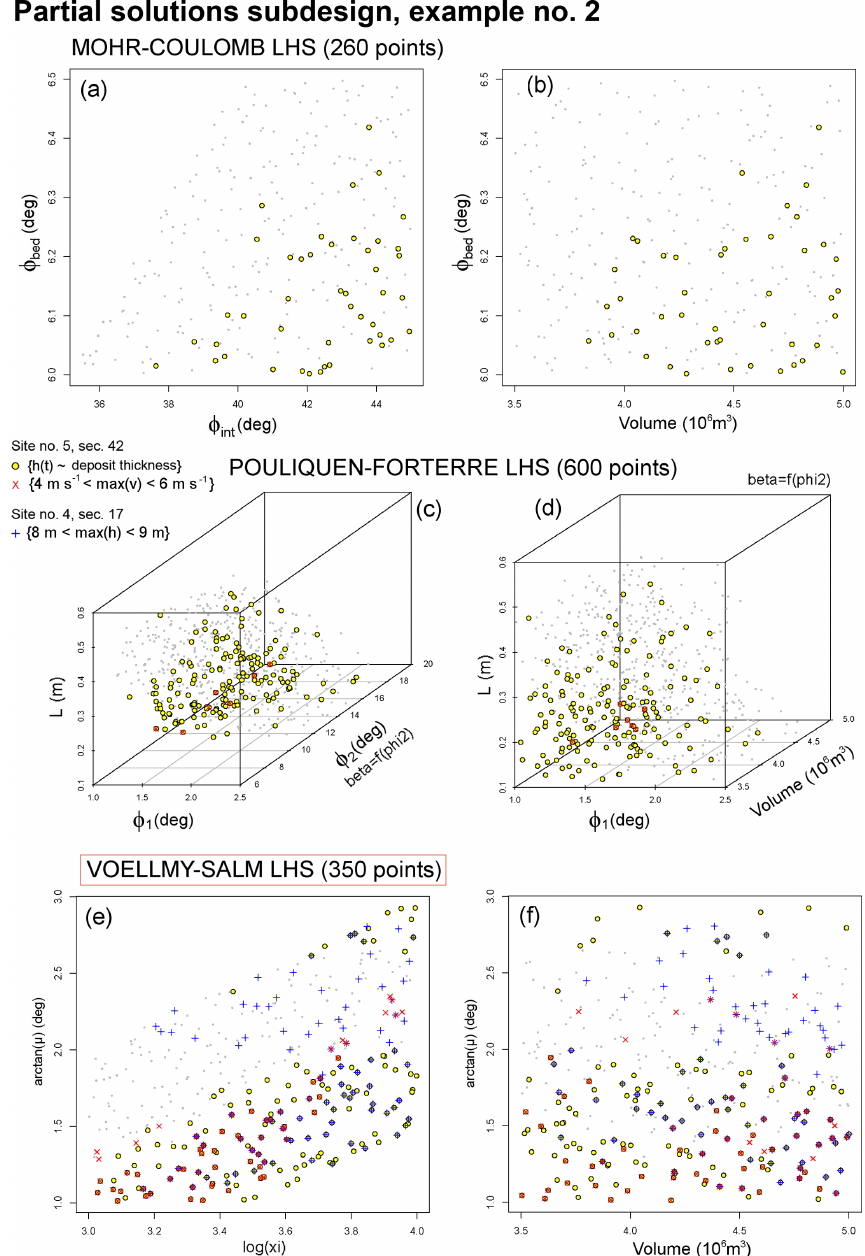
Figure 15. Example 2 of partial solution inputs in the (a, b) MC, (c, d) PF, and (e, f) VS experimental designs. Panels (a, c, e) are projected along the V coordinate and (b, d, f) are projected along φ int , φ 2 , and ξ coordinates. The color expresses the considered data: yellow is deposit thickness at Site 5 (Saucedo et al., 2008), blue is wave height at Site 4 (Ponce-Segura, 1983), and red is peak flow speed at Site 5 (Pierson,